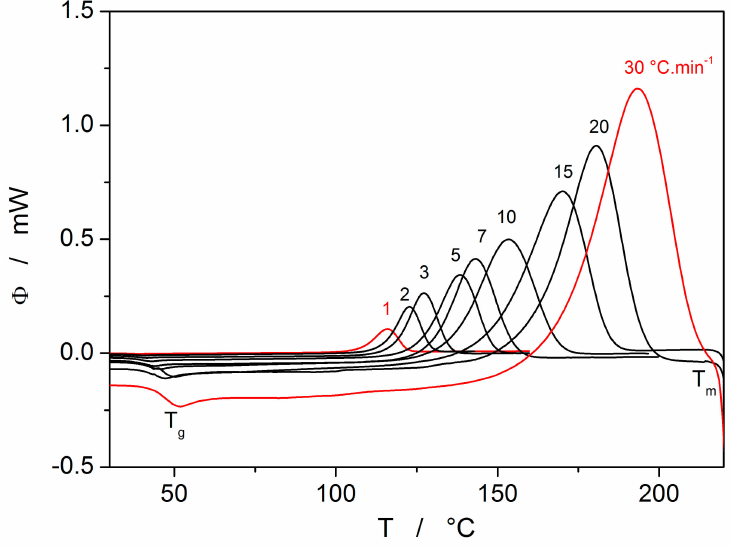
Figure 5. The DSC measurement of bulk selenium glass at di ff erent heating